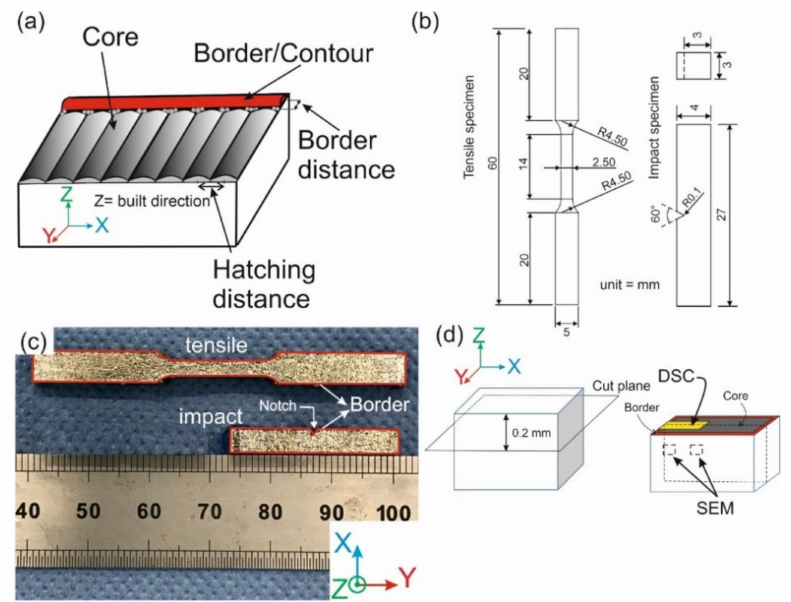
Figure 1. ( a ) Schematic view of laser scanning showing the notions of border, core, hatching distance, and border distance for a part of a sample, ( b ) geometry of the tensile and impact specimens, ( c ) a tensile and an impact specimen fabricated via LPBF, and ( d ) schematic view of the samples showing locations of SEM and DSC analyses with respect to the core and border